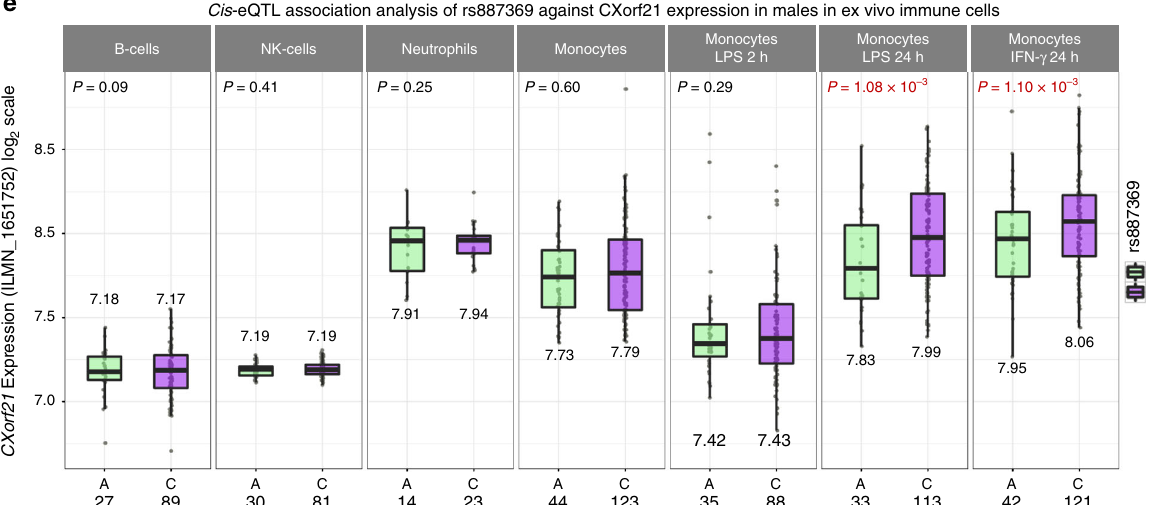
Fig. 2 eQTL association analysis of SLE associated risk SNP rs887369 in immune cell types. a Cis -eQTL analysis of rs887369 using male samples of the Geuvadis RNA-Seq expression cohort pro fi led in LCLs. The MAGEB family of genes and NR0B1 were not expressed in LCLs (RPKM<1). Allele [C] of rs887369 tags the risk haplotype. The number underneath each box-plot represents the mean of the group and the number underneath the x -axis refers to the number of inviduals in each group. b Cis -eQTL analysis performed for all SNPs in cis (±1 Mb) to rs887369 against CXorf21 expression using the males of the Geuvadis cohort. The coordinate of each SNP is plotted on the x -axis and the – log 10 (P) value of association on the y -axis; rs887369 is highlighted as the best eQTL. c cis -eQTL analysis of rs887369 against CXorf21 expression in LCLs from the TwinsUK cohort using only females who exhibit non-skewed patterns of X-chromosome inactivation (see methods). d Relative protein abundance of CXORF21 in LCLs from females strati fi ed on genotype at the rs887369 SNP. Relative abundance normalised against beta-actin loading control. Source data are provided in the Source Data fi le ( e ) Cis -eQTL analysis of rs887369 using the microarray data from the Fairfax et al. 45,46 and Naranbhai et al. 47 cohorts in primary ex vivo immune cell types (see Methods). The remaining cis -genes did not pass quality control. Box-plots show minimum (Q1 – 1.5*IQR), 25th percentile (Q1), Median, 75th percentile (Q3) and maximum Q3 +